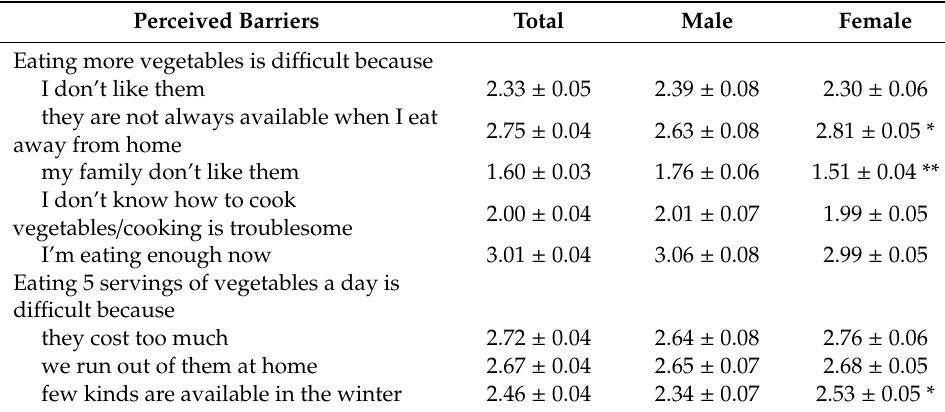
Table 3. Mean scores of perceived barriers to vegetable intake.